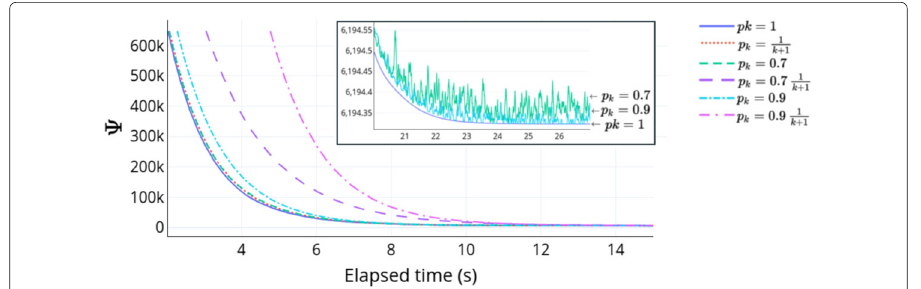
Fig. 8 Comparison between using different values of p k ≤ 1, first order method, unidirectional communication, Conll data